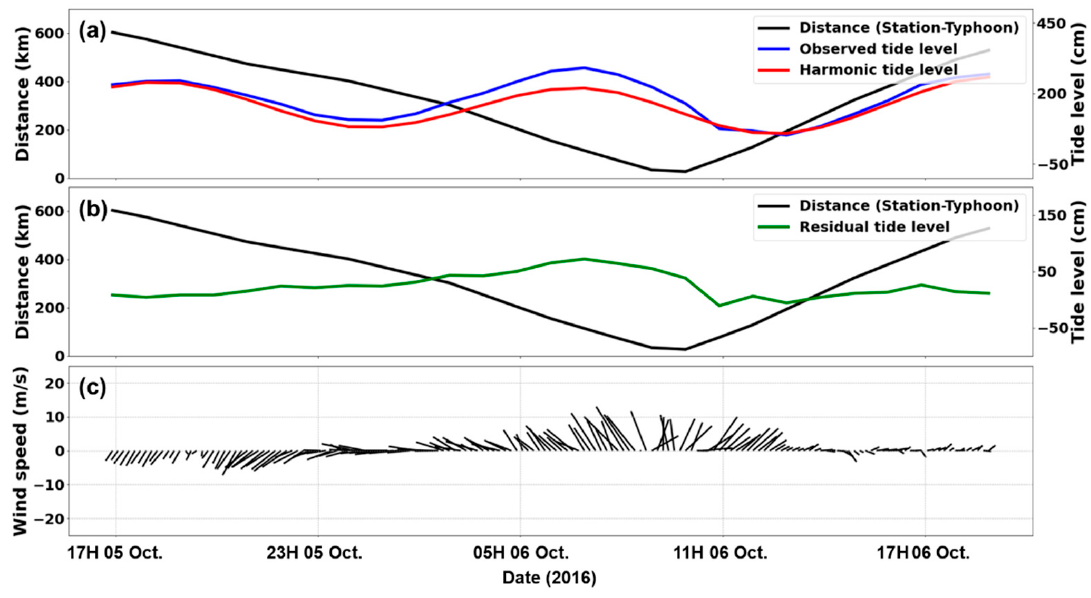
Figure 13. Time-series of observational data from Tongyeong tidal station during Typhoon Kong-Rey. ( a ) Astronomical tide, ( b ) residual tide level, and ( c ) wind components, where direction and length represent wind direction and speed, respectively.